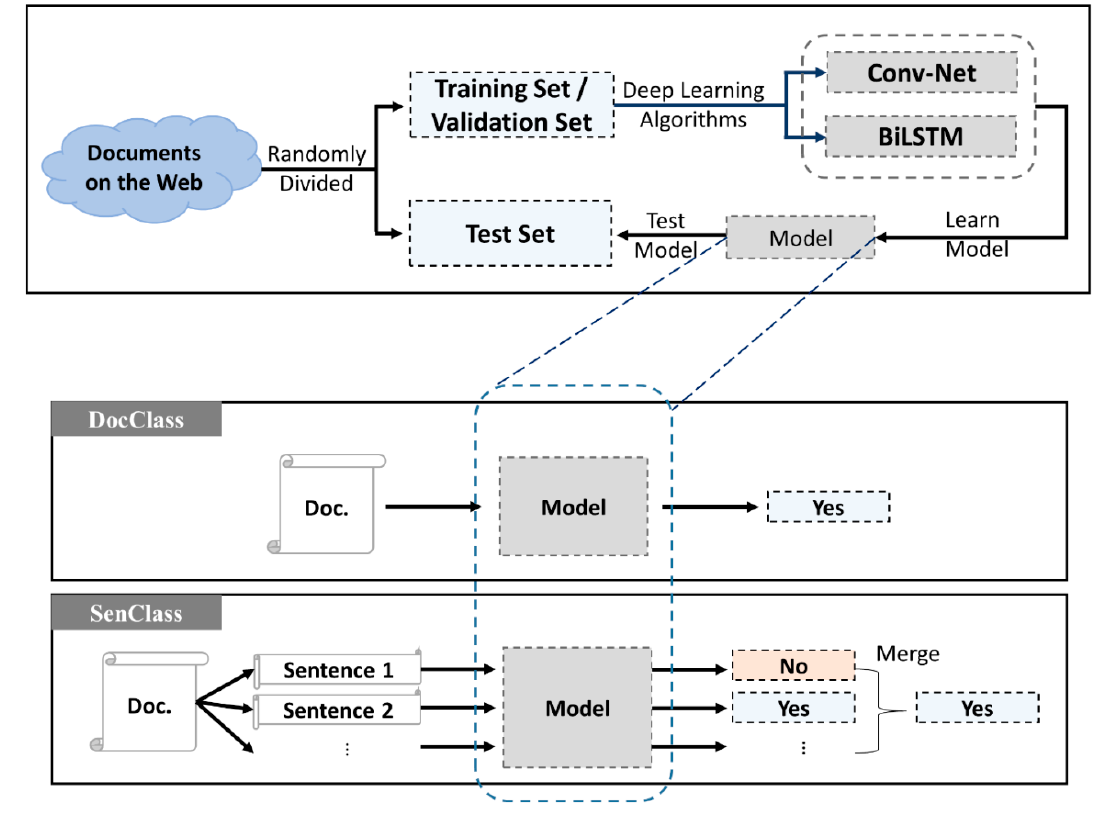
Figure 1. The two machine learning algorithms and classification methods used in the infectious disease occurrence detection experiments. BiLSTM: bidirectional long short-term memory.